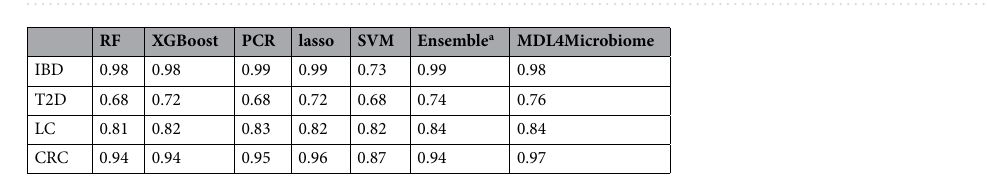
Table 3. The accuracy of our model and conventional machine learning models. a Ensemble of PCR, lasso, and